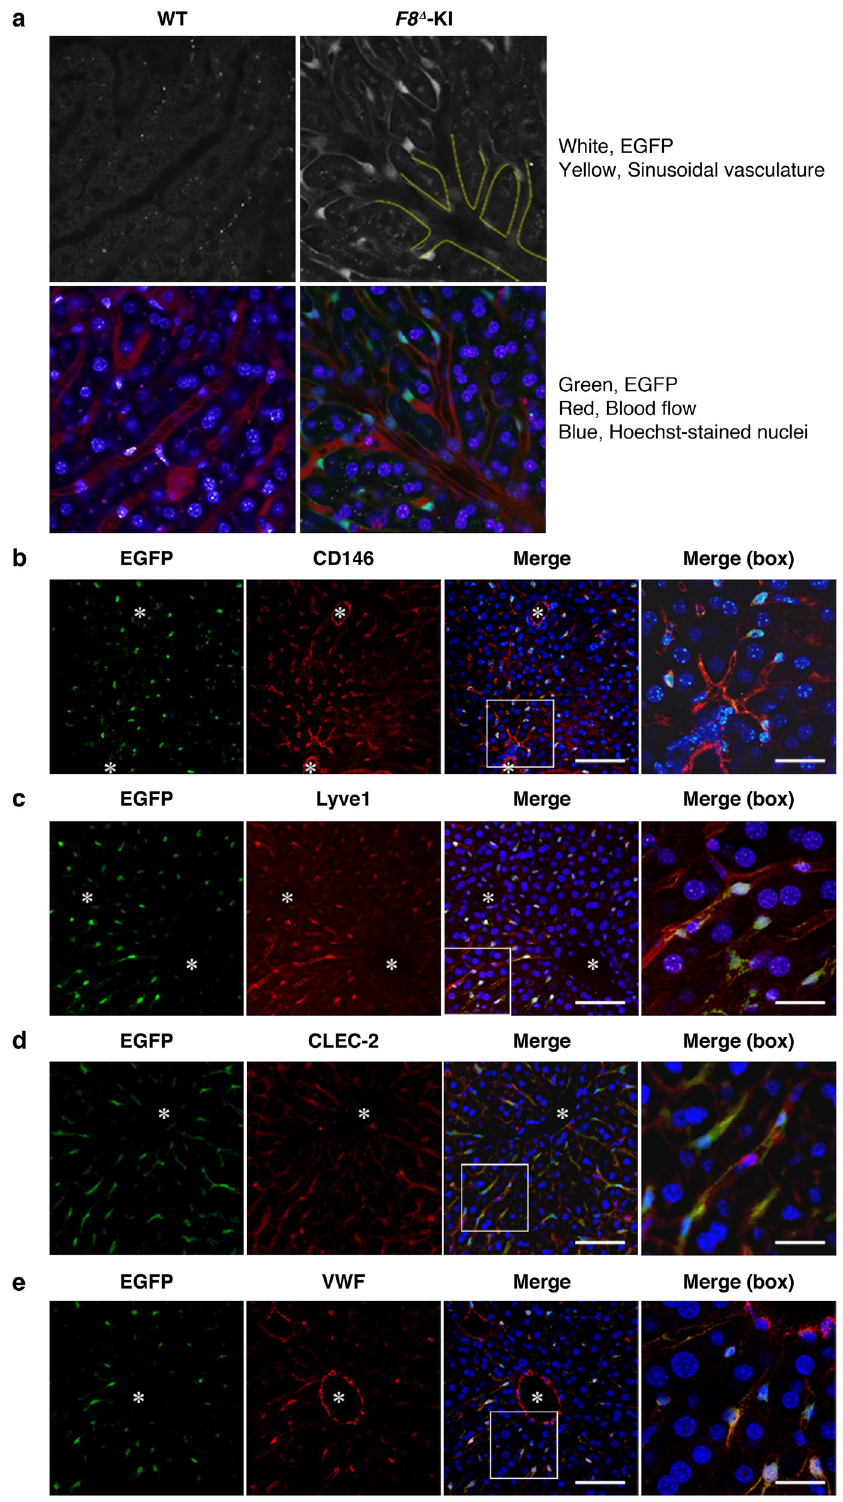
Figure 3. Histological localization of EGFP-positive cells in F8 Δ knock-in mice. ( a ) Intravital imaging in the liver of adult WT and F8 Δ -KI male mice was observed by intravital confocal microscopy. Red, blood flow; blue, Hoechst-stained nuclei; white (upper) and green (lower), EGFP. Yellow lines in the top panel indicate thick sinusoidal vasculature. ( b – e ) Liver sections obtained from adult F8 Δ -KI mice were subjected to immunofluorescence staining for EGFP and CD146 ( b ), EGFP and Lyve1 ( c ), EGFP and CLEC-2. ( d ), and EGFP and VWF. ( e ) Nuclear localization was simultaneously examined by DAPI staining. Confocal microscopy was used to observe the localization of each antigen, nucleus, and their merged image. The magnifications of the boxed areas in the merged image are shown in the right panel. Scale bars: 75 μm in merged images and 25 μm in magnification of the merged images; *central vein (n =